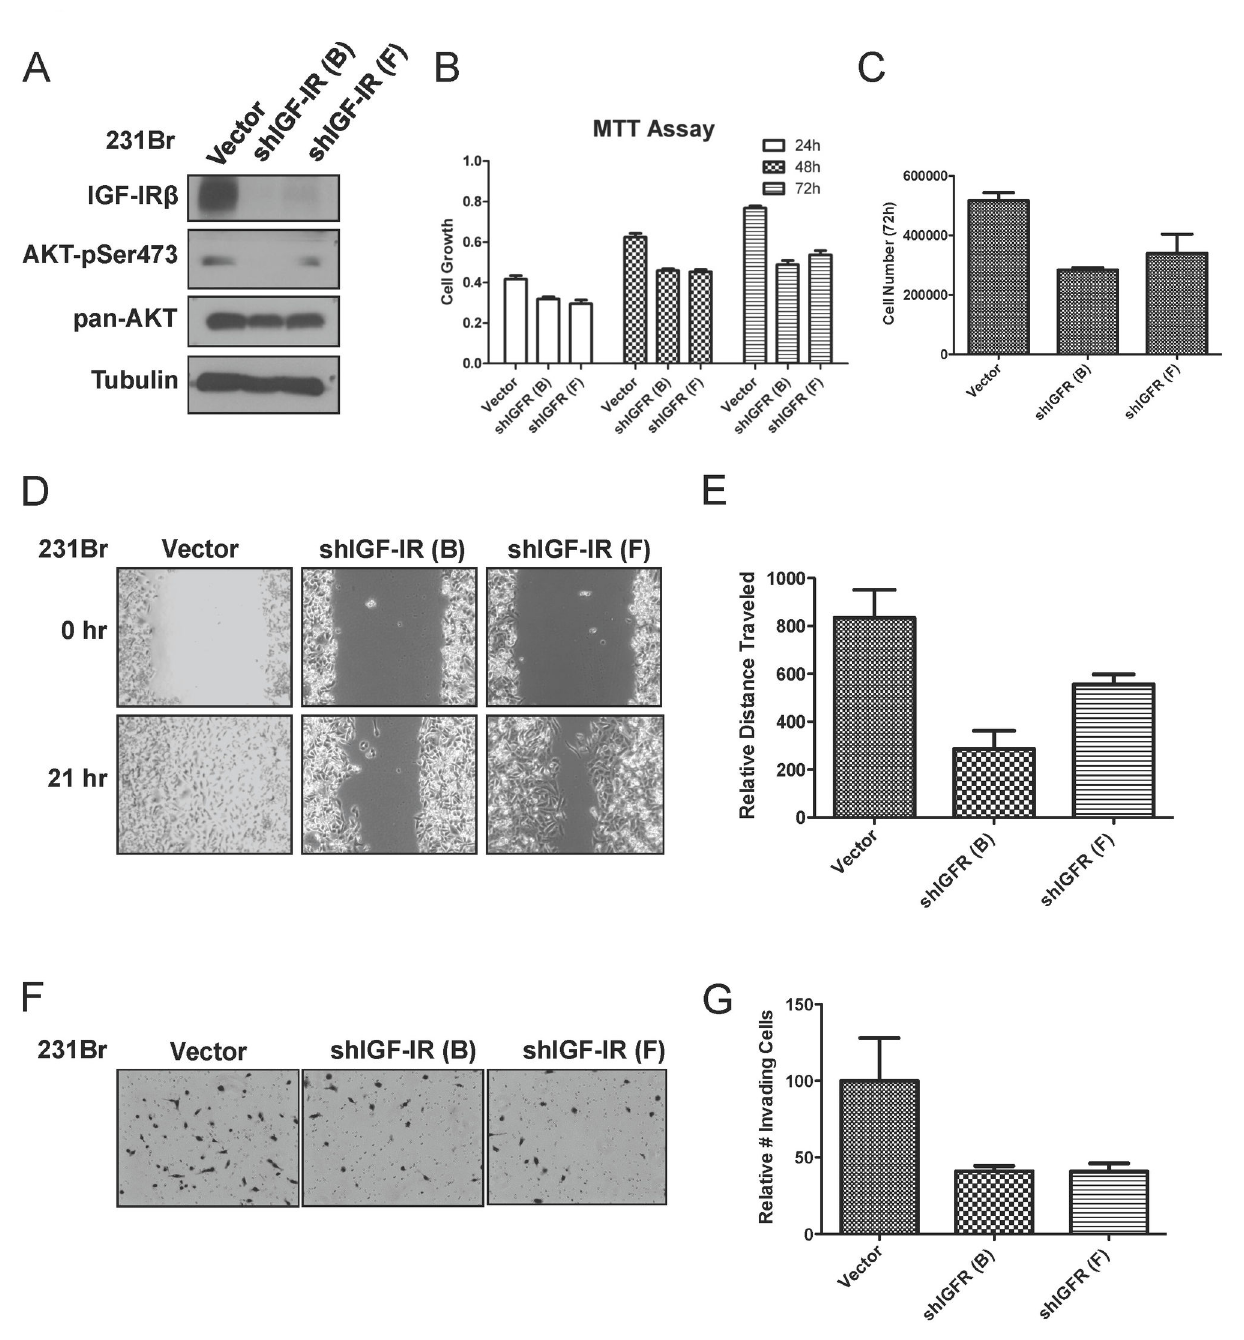
Figure 3. IGF-IR knockdown in brain-seeking breast cancer cells suppresses proliferation, invasion and migration in vitro . A, Immunoblot of IGF-IRβ and AKT total and phospho-Ser473 expression in 231Br cells stably transfected with control shRNA (vector) or IGF-IRβ shRNA (shIGF-IR B and F clones). B, MTT assay of control and IGF-IR beta knockdown cells at 24, 48 and 72 hr. Values represent mean ± SEM. C, Vector control and shIGF-IR 231Br cells were seeded 100,000 cells per well and were counted after 72 hr. D, Wound-healing assay of vector and shIGF-IR 231Br cells. Images are representative of triplicates at 0 and 21 hr. E, Quantitative measurement of wound closure area from (D). Data were calculated from one representative experiment out of three performed. F, Matrigel invasion assay of vector and shIGF-IR 231Br cells performed in triplicate over 24 hr with complete medium as a chemoattractant. G, Quantitative analysis results of one representative experiment out of three performed in triplicate from (F). Values represent mean ± SEM. doi: 10.1371/journal.pone.0073406.g003 PLOS ONE |